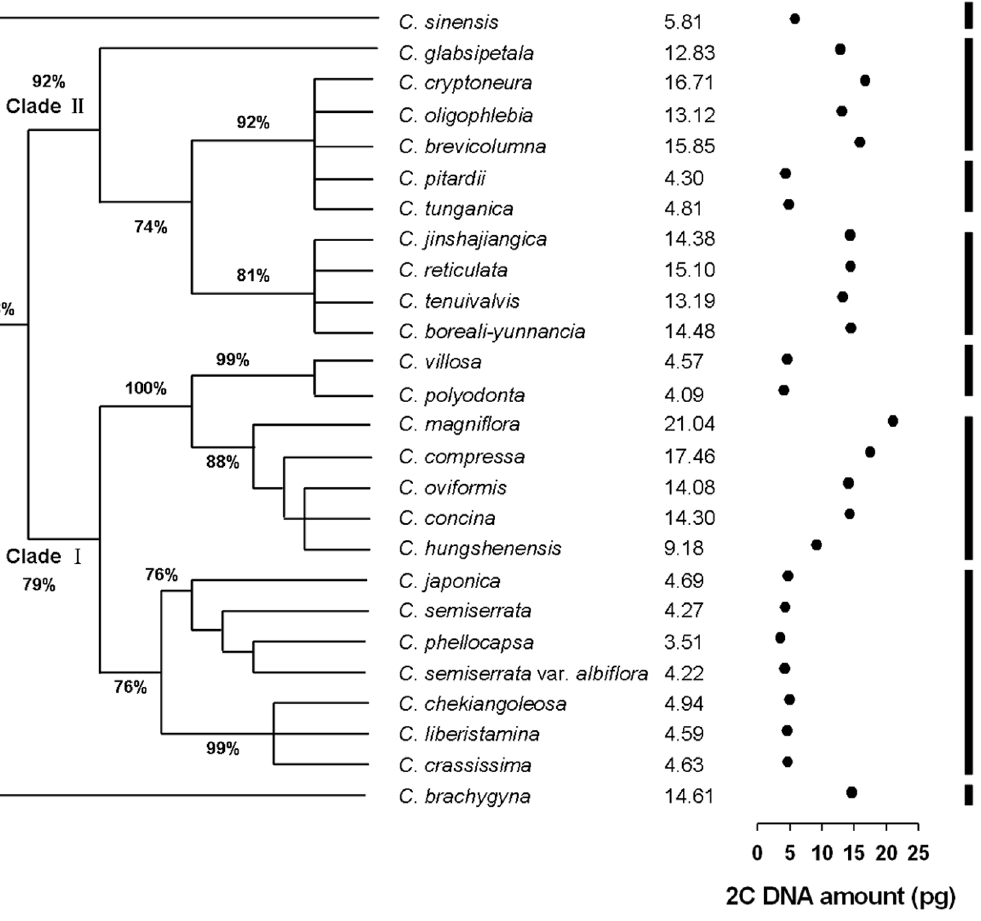
Figure 5. Nuclear DNA contents and evolutionary relationships among species of the section Camellia [ 31 ] . The phylogenetic tree was N constructed based on ITS sequences [45]. The estimated 2C-values are shown on the right of each species, while the 2C DNA amount (pg) is given by for each species.